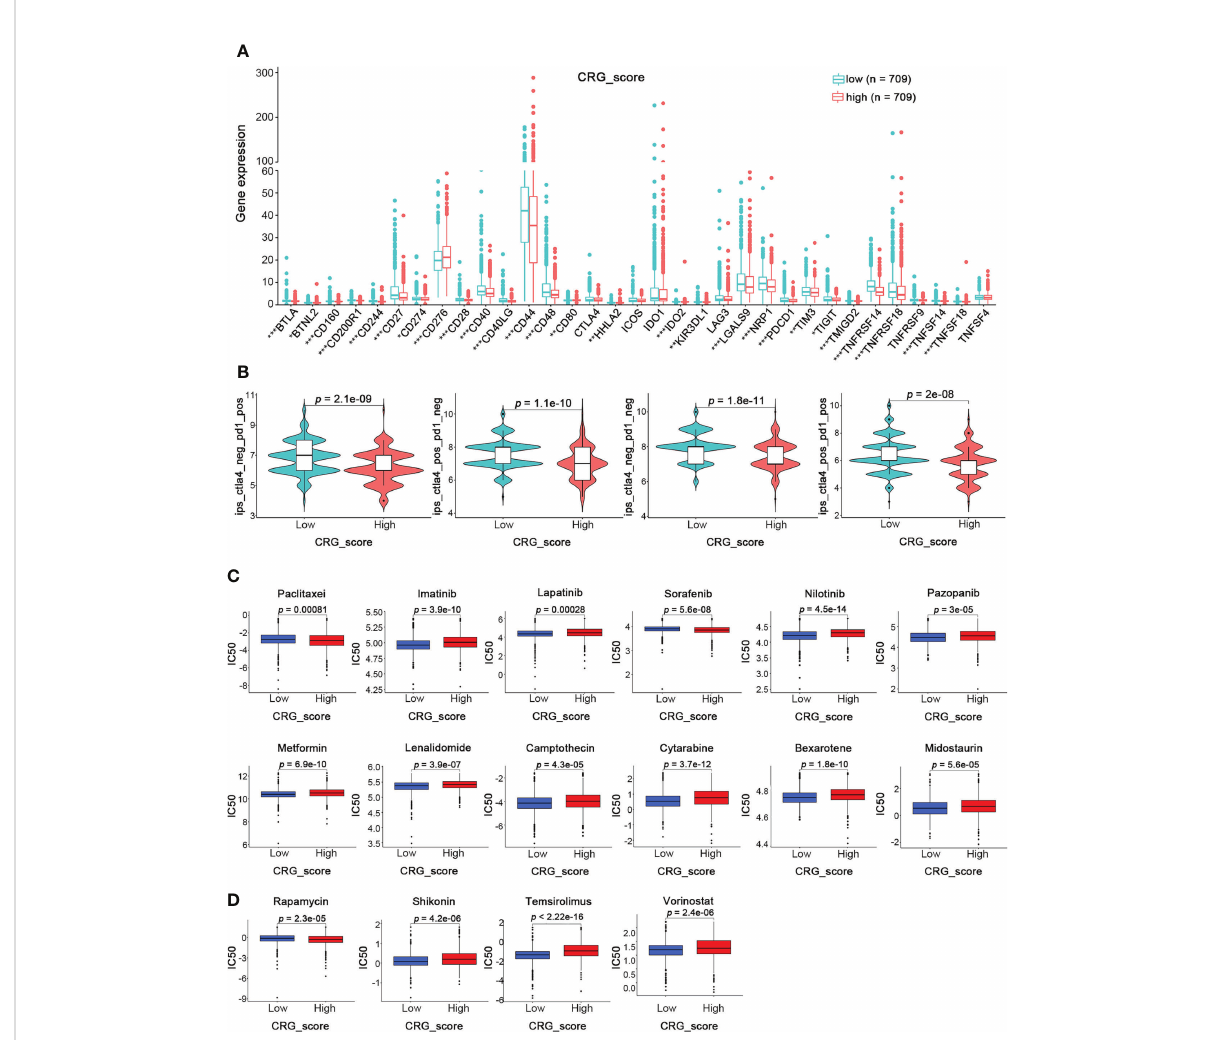
FIGURE 9 Prediction of Immunotherapy Response in High- and Low-CRG_score groups in BRCA. (A) The expression levels of 32 immune checkpoints in the high and low CRG_score groups (Wilcoxon test). (B) The immunotherapy response between the high and low CRG_score groups (Wilcoxon test). (C) The relationships between CRG_score and chemotherapeutic sensitivity (Wilcoxon test). * p < 0.05, ** p < 0.01, *** p <